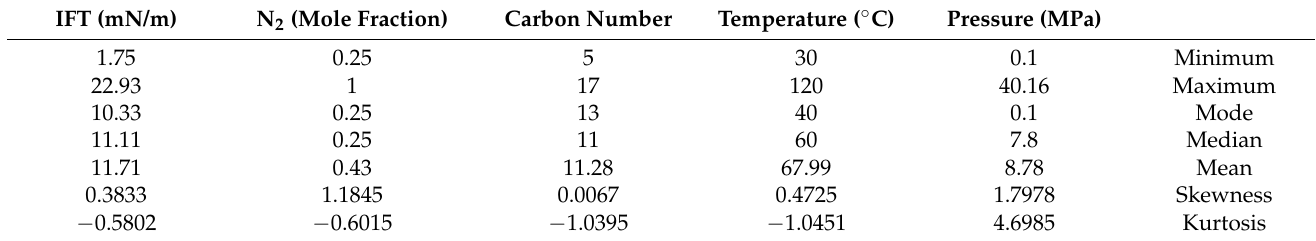
Table 1. Statistical data of each column of inputs and target